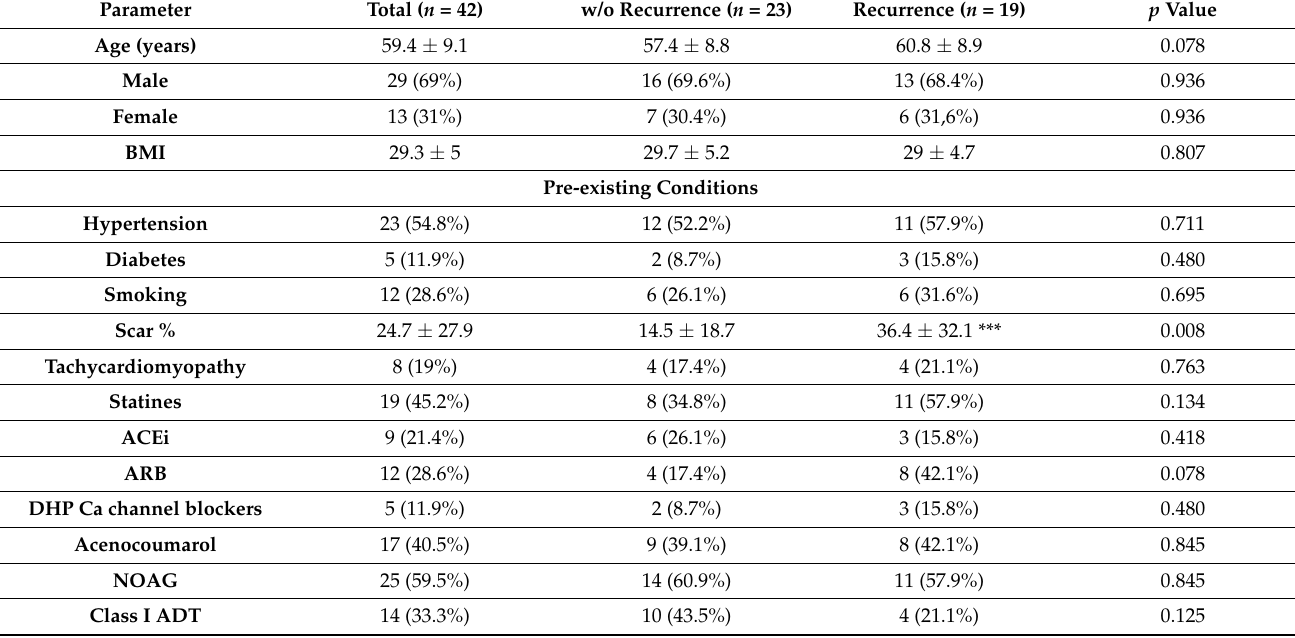
Table 1. Clinical parameters. Data are presented as mean + SD, n